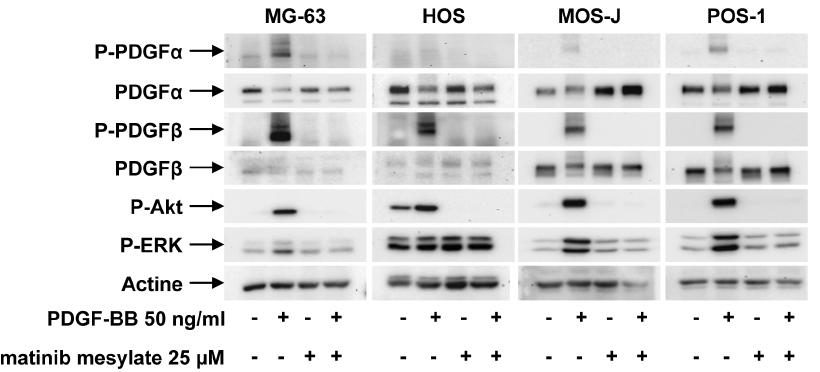
Figure 8. Imatinib mesylate inhibits the PDGF-BB induced signalling pathways. Human, mouse and rat osteosarcoma were treated with 50 ng/mL of PDGF-BB for 5 minutes in the presence of the absence of 25 m M of imatinib mesylate. PDGFR a , PDGFR b , Akt, ERK1/2 phoshorylations were analyzed by Western blot compared to the levels of total forms of proteins and the levels of actin.